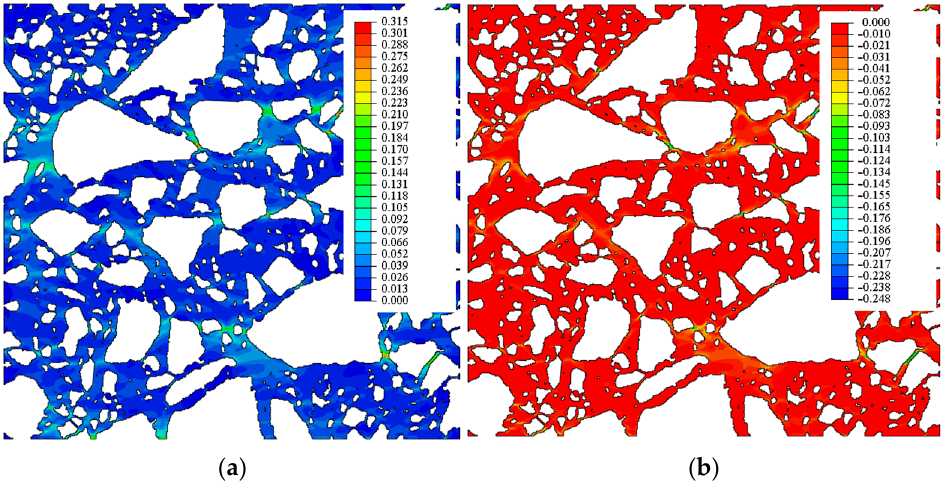
Figure 12. Contour graphs of principal strains: ( a ) maximum and ( b ) minimal in the mortar.